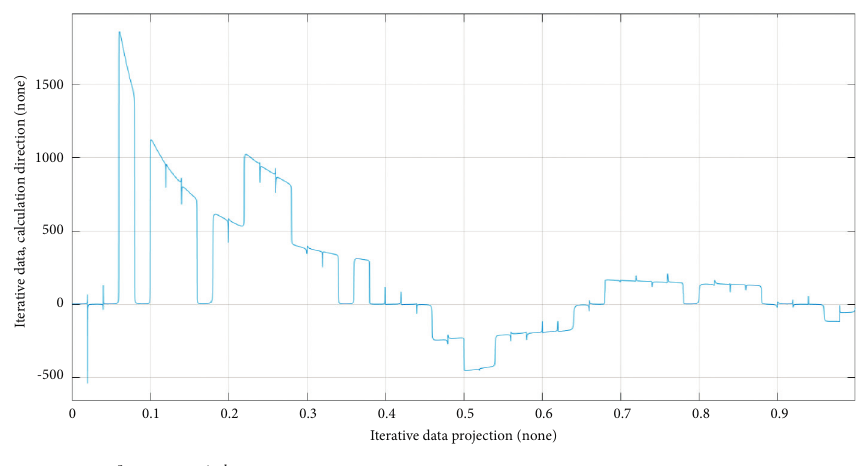
Figure 4: The calculation direction of the improved artificial bee colony